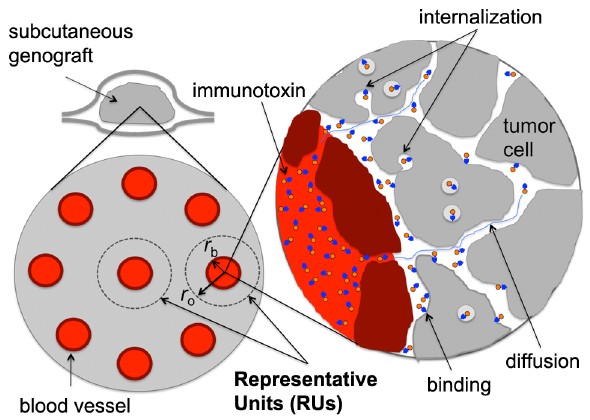
Figure 1. The vascular tumor model. It consists of a collection of representative units (RUs), each a cylinder of radius r 0 centered on a cylindrical blood vessel of radius r b , which serves as the source of the administered immunotoxin. The values of r b and r 0 used were 11 and 50 m m, respectively. Expanded view: The immunotoxin molecules, each represented as a small orange circle with a blue arrowhead, leave from blood vessel by permeating through the blood vessel wall into the extra-cellular space of the tumor tissue, diffuse in this space, bind to surface antigen molecules, and then become internalized by endocy-